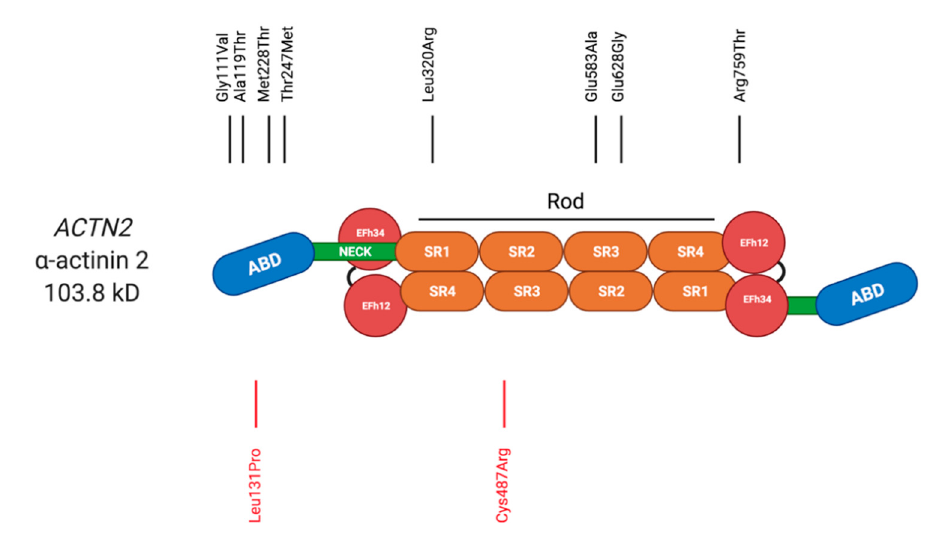
Figure 1. Schematic representation of α -actinin shown as a dimer with variants in the ACTN2 gene that have been previously reported in individuals with myopathy (red) or cardiomyopathy (black). Solid lines represent missense variants. ABD—actin binding domain, EFh—EF hand, SR—spectrin like repeat. Created with BioRender.com (access on 07/03/2021). Adapted from [16].